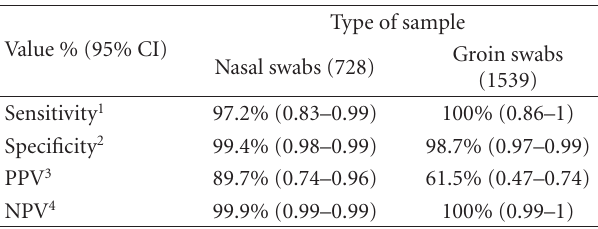
Table 2: Comparison of BD GeneOhm MRSA Assay and culture in the detection of MRSA with groin swabs Groin swabs